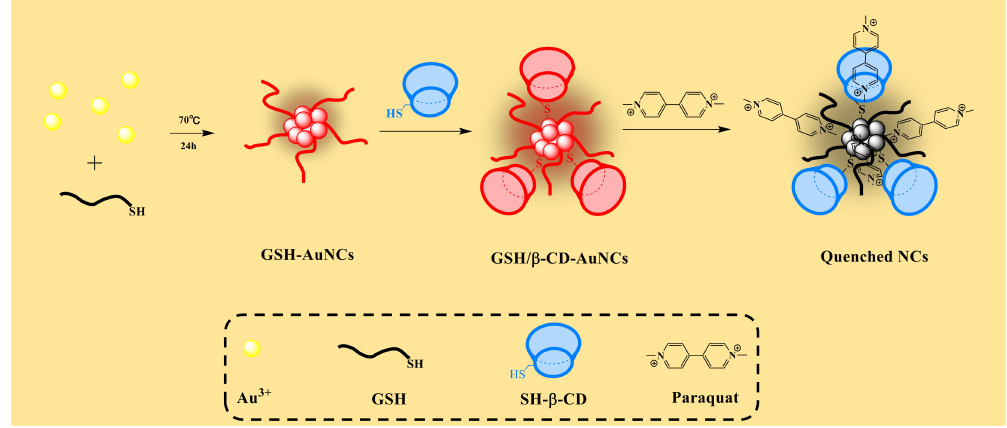
Scheme 1. The GSH/ β -CDs-AuNC synthesis method and mechanism of GSH/ β -CDs-AuNC fluorescence quenching induced by